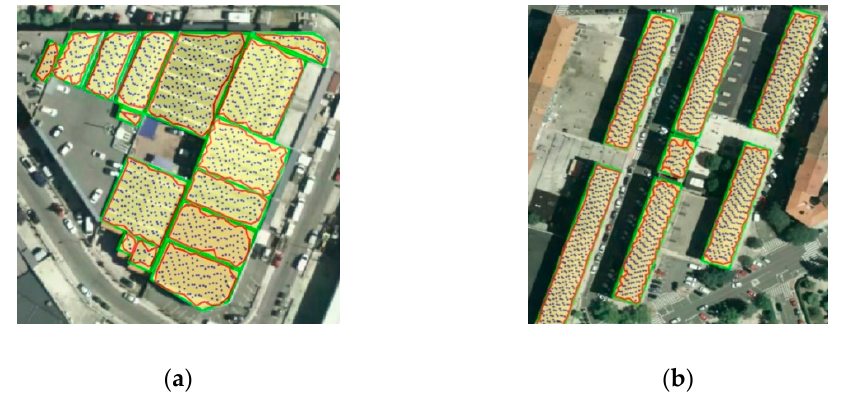
Figure 8. Graphic results of the projected area of reference defined from aerial orthophotographs (green line) and projected area computed from point cloud (red line): ( a ) industrial and ( b ) residential.